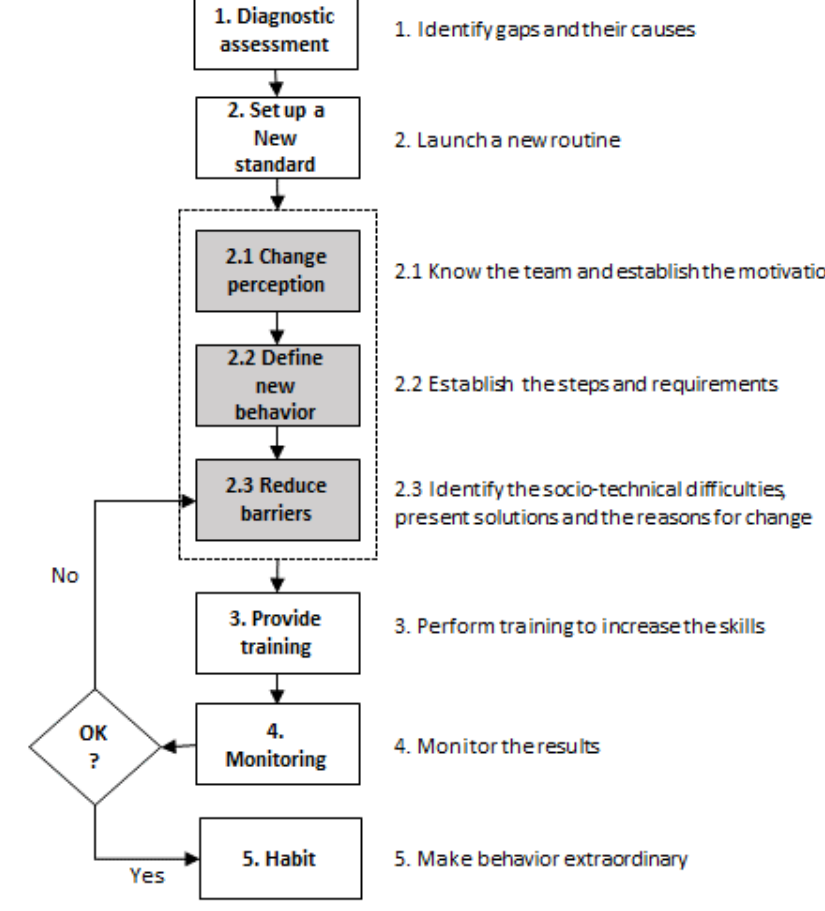
Figure 3. The proposed framework.